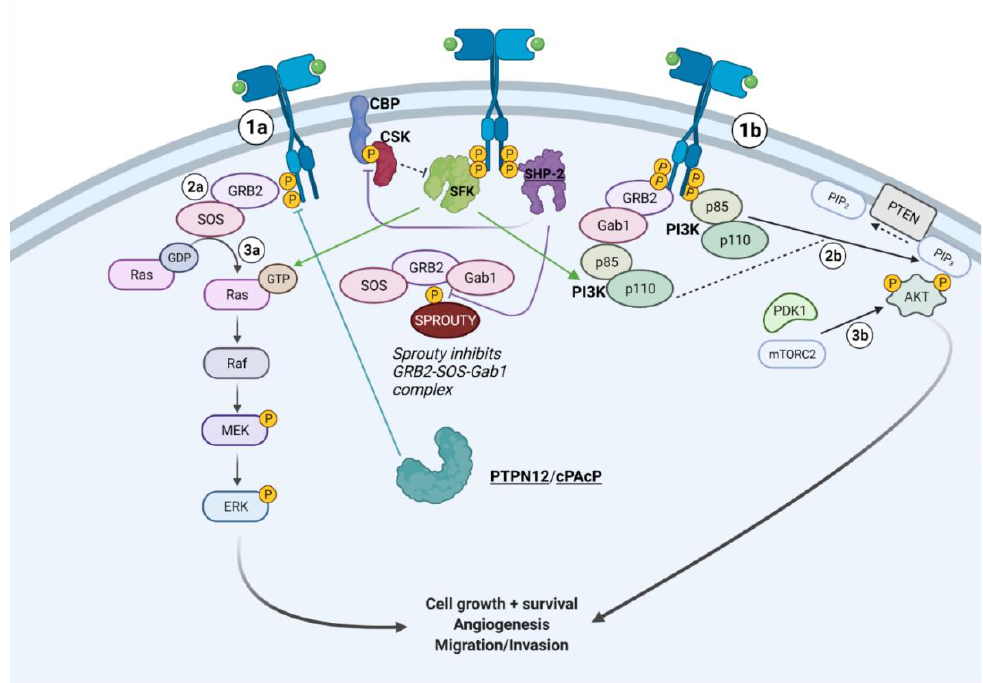
Figure 3. PTPs that affect RTK-associated PI3K-AKT and Ras-Raf-Mek-Erk Signaling. The PI3K-AKT pathway and MAPK signaling cascade are downstream of RTKs. The GRB2-SOS-Gab1 complex can enhance PI3K and MAPK signaling. Furthermore, PI3K is recruited to intracellular phosphotyrosine residues of activated RTKs. PTPs dephosphorylate inhibitors (CBP = Csk binding protein) of these oncogenic pathways (SHP-2), or dephosphorylate the RTK itself (PTPN12, cPAcP). For a more in-depth discussion of the mechanism of action for each PTP, refer to Table 3. Adapted from “PI3K/Akt, RAS/MAPK, JAK/STAT Signaling,” by BioRender.com (28 September 2021). Retrieved from https://app.biorender.com/biorender-templates (28 September 2021).